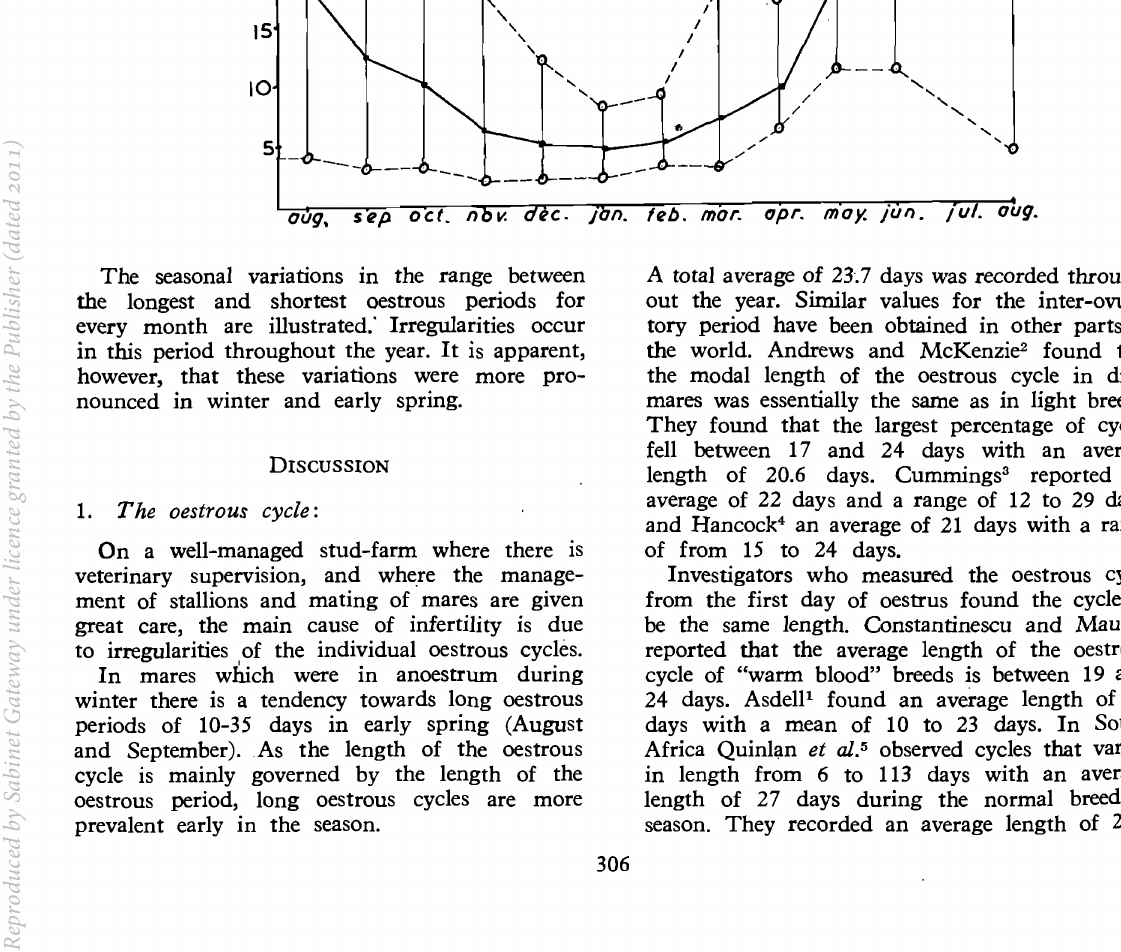
fflb. mar. Dpr. may. jun. IU!.